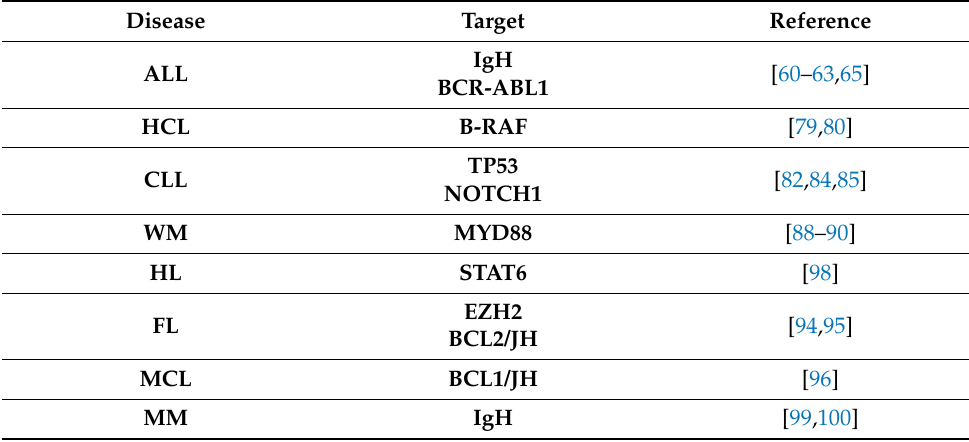
Table 1. ddPCR and lymphoproliferative